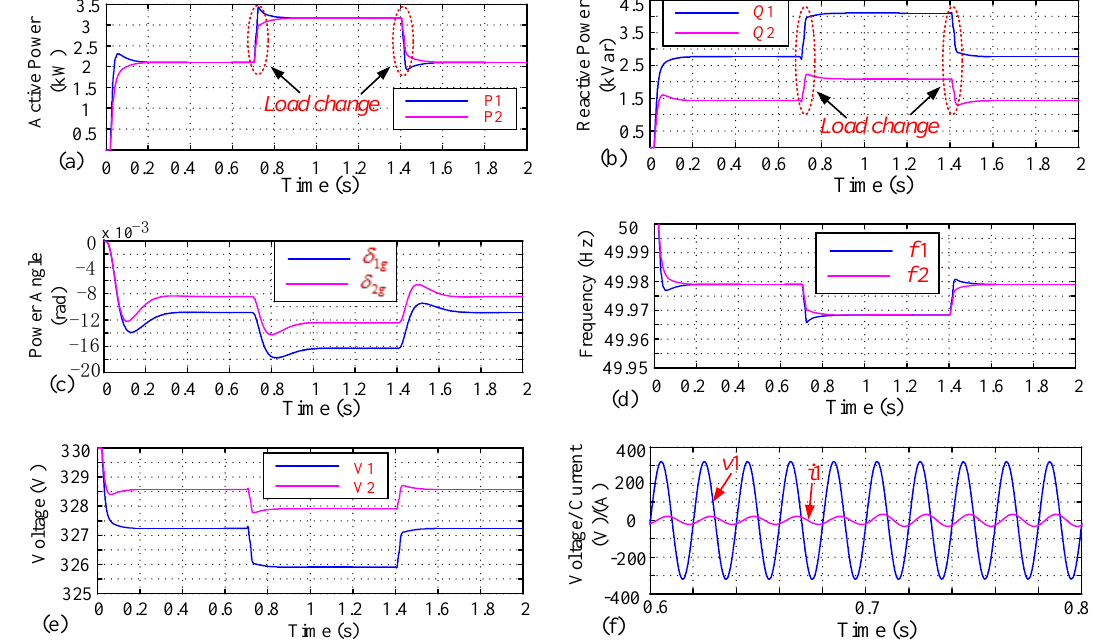
Figure 7. Simulation results in Case A: ( a ) active power; ( b ) reactive power; ( c ) power angle; ( d ) frequency; ( e ) voltage amplitude; and ( f ) voltage and current of DG1.